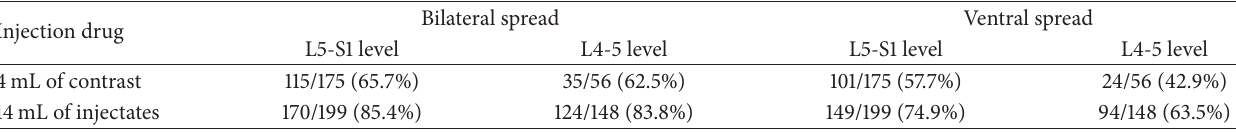
Table 1: The rates of bilateral and ventral drug spread at L4-5 and L5-S1 disc levels after injection of 4mL of contrast medium or 14mL of injectates.